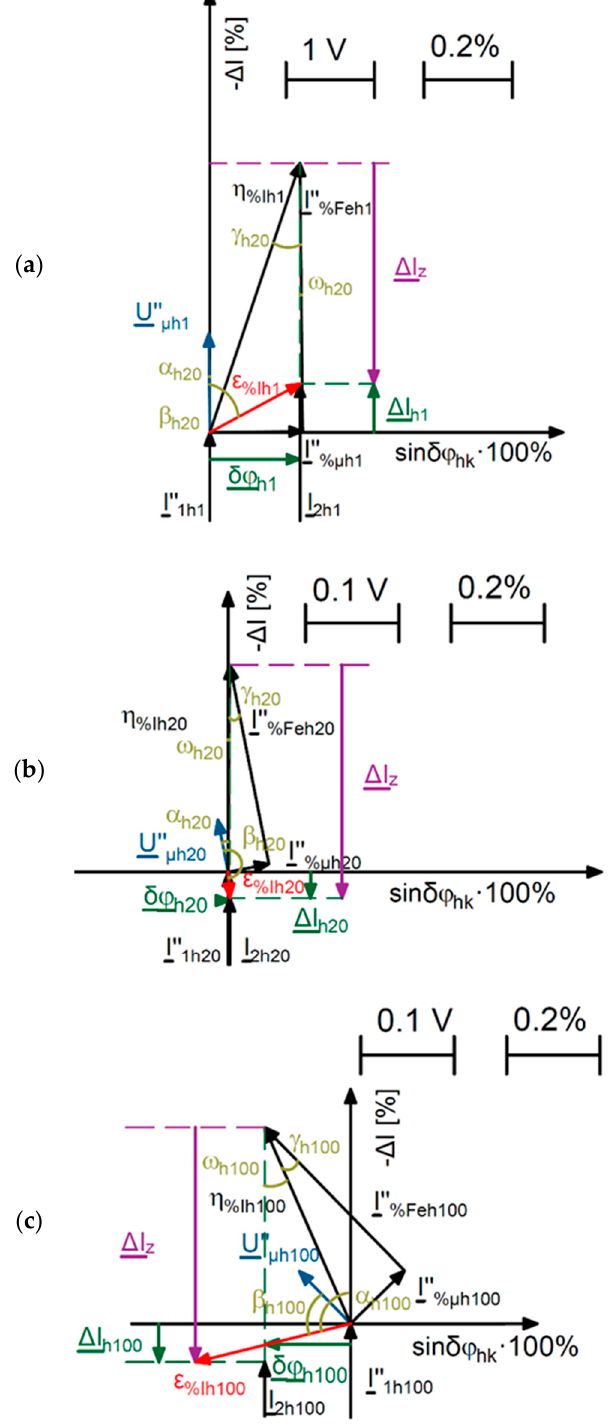
Figure 10. Vectorial diagrams constructed for the tested CT for a given harmonic: ( a ) 1st harmonic, ( b ) 20th harmonic, ( c ) 100th harmonic.